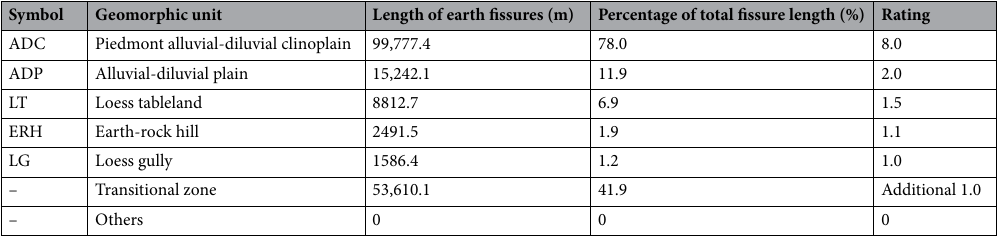
Table 2. Ratings of geomorphic